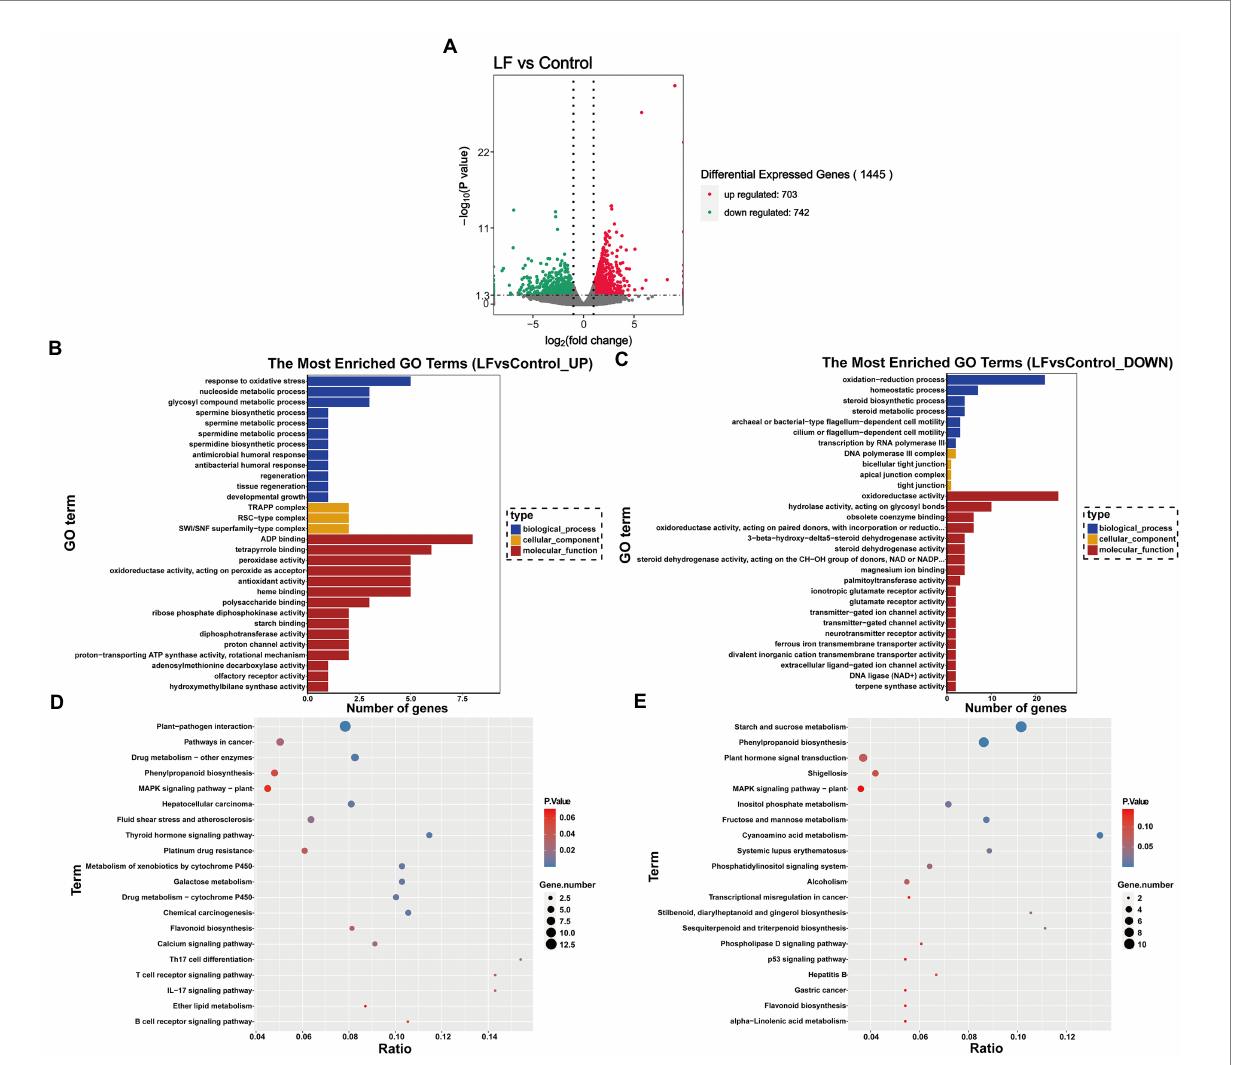
FIGURE 2 Functional enrichment analysis of differentially expressed genes. (A) Differential gene volcano map; (B) GO enrichment histogram of up-regulated differential genes; (C) GO enrichment histogram of down-regulated differential genes; (D) KEGG enrichment scatter diagram of up-regulated differential genes; (E) KEGG enrichment scatter plot of down-regulated differential